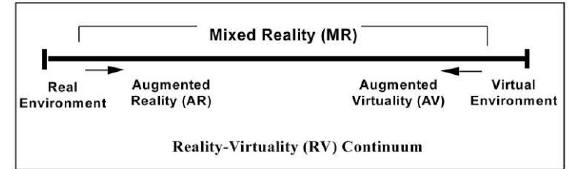
Figure 1. “Continuo Real-Virtual” en Milgran y Kishino